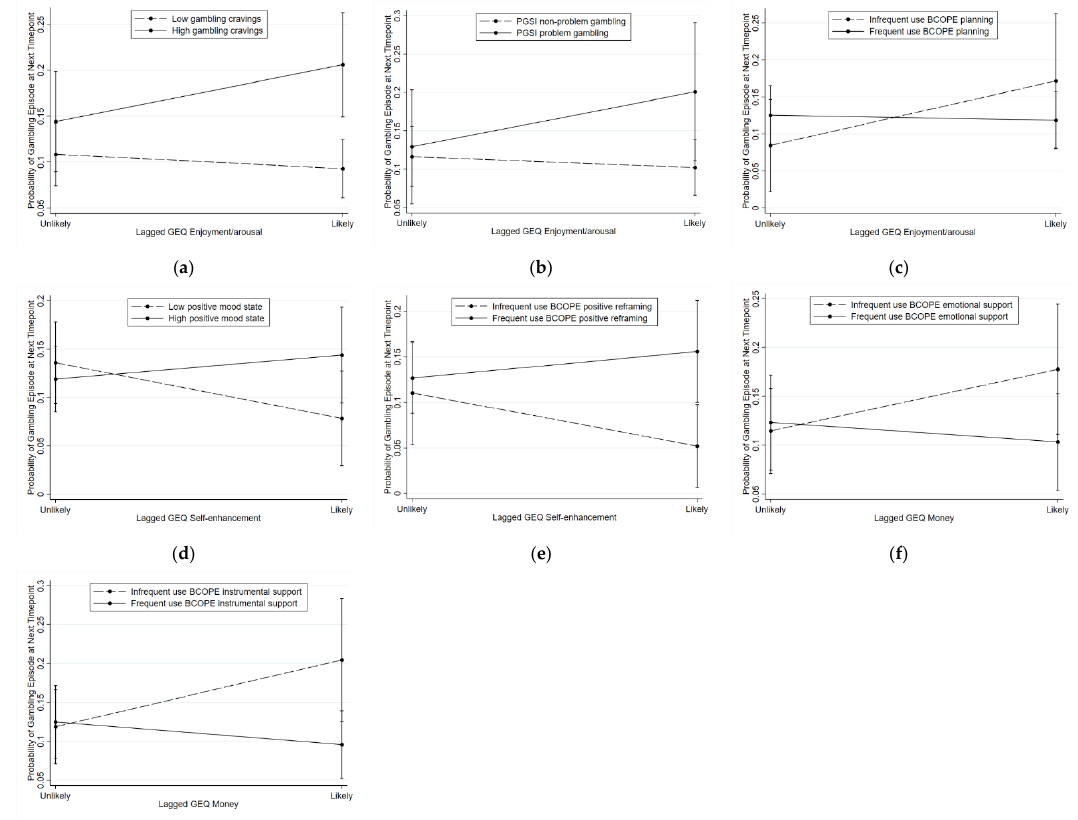
Figure 1. Significant ( p < 0.03) interaction effects on reciprocal relationships between EMA gambling outcome expectances and gambling episodes a . ( a ) Participants who reported experiencing high cravings (vs. low cravings) had a higher prob- ability of reporting a subsequent gambling episode if they endorsed enjoyment/arousal expectancies ( p < 0.001). There was no difference between participants who reported experiencing an urge (vs. no urge) if they did not endorse enjoy- ment/arousal expectancies ( p = 0.123). ( b ) Participants who reported problem gambling (vs. non-problem gambling) had a higher probability of reporting a subsequent gambling episode if they endorsed enjoyment/arousal expectancies ( p